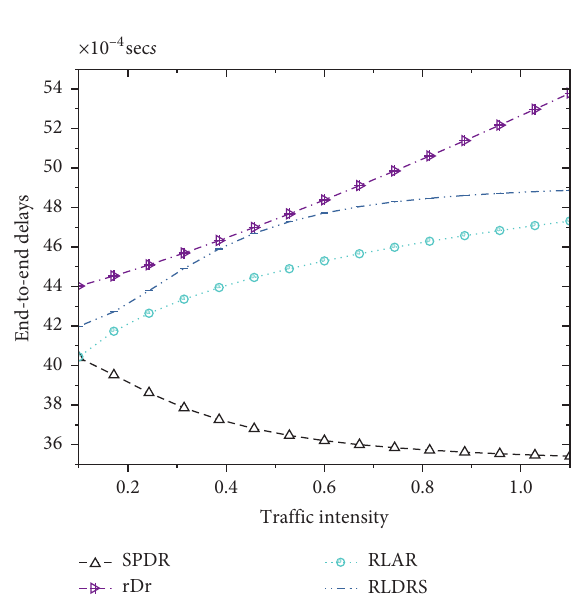
Figure 11: Average end-to-end burst